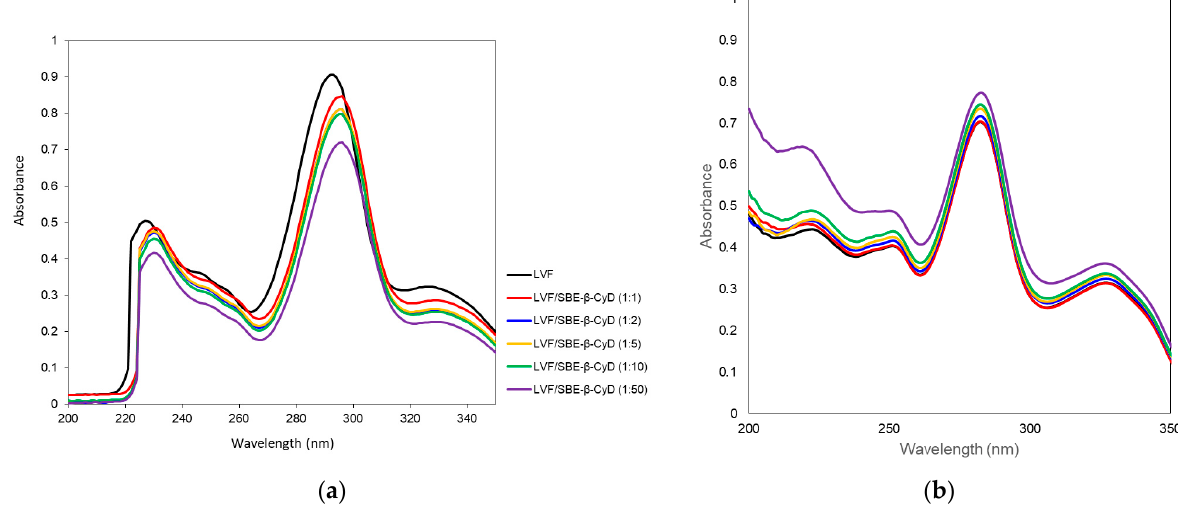
Figure 2. UV–vis spectra of LVF alone and in the presence of an increasing amount of SBE- β -CD at pH 5 ( a ) and in PBS pH 7.4 ( b ).